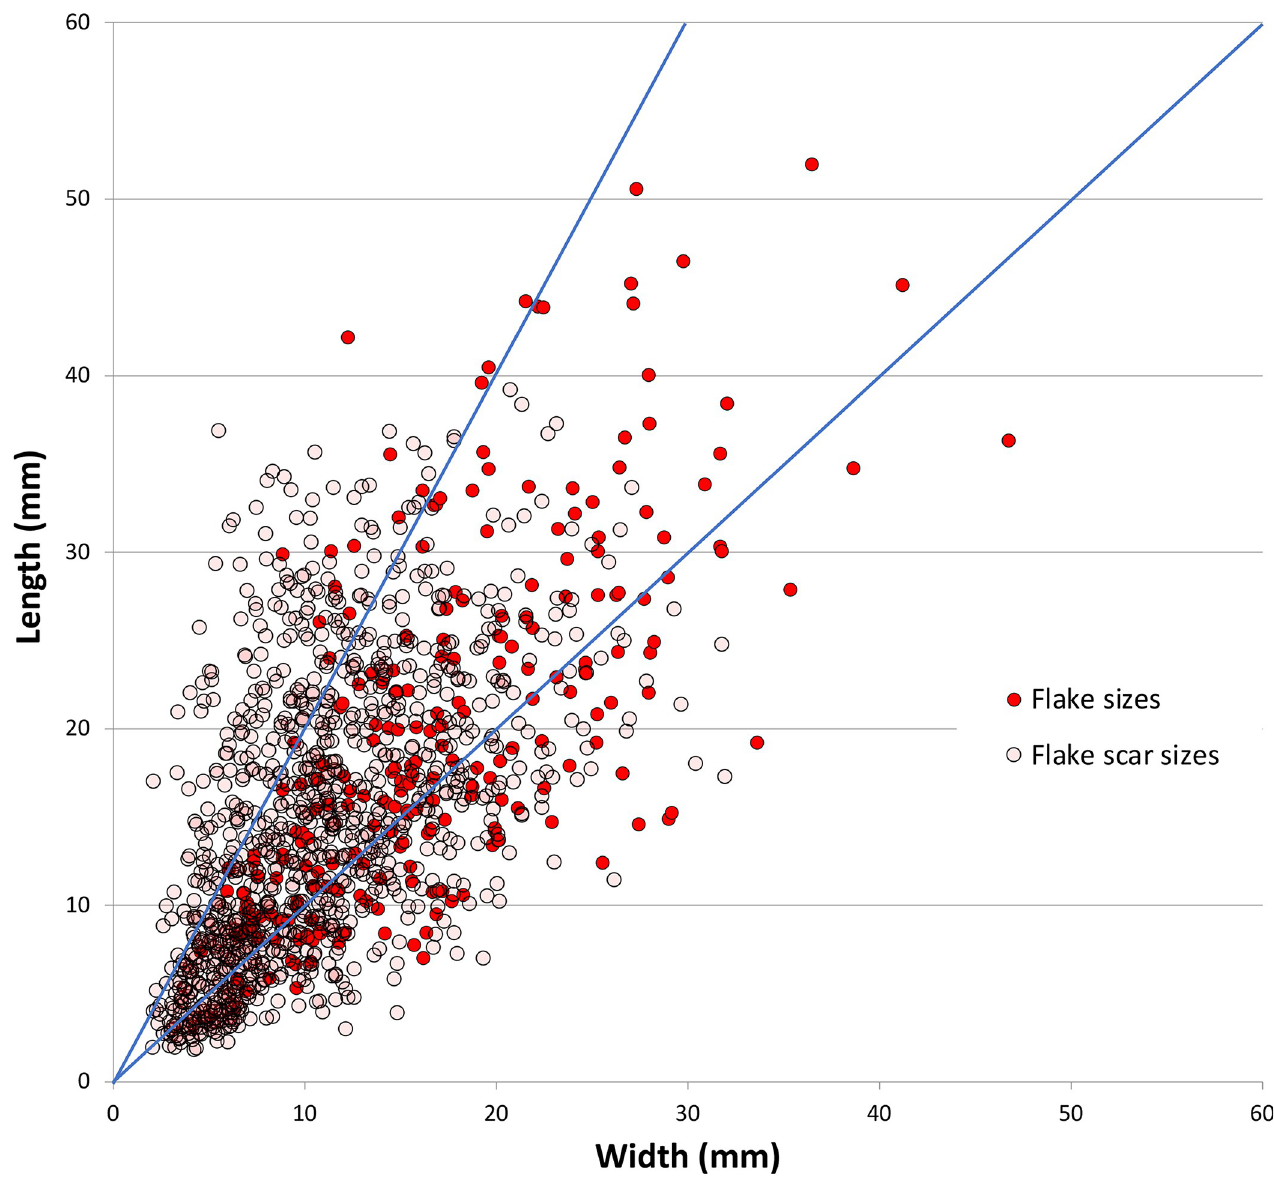
Fig 18. Scatterplot comparing the elongation of complete flakes and flake scars on cores, Horizon IV, Saruq al-Hadid.